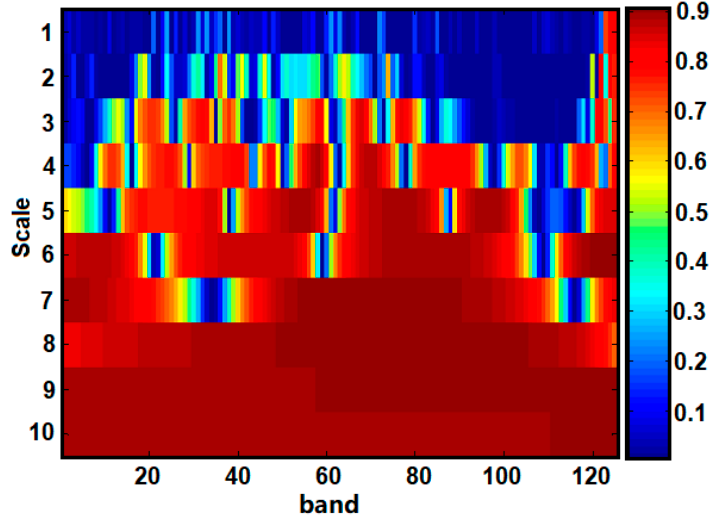
Figure 5. Characteristics analysis and correlation analysis of CWT.